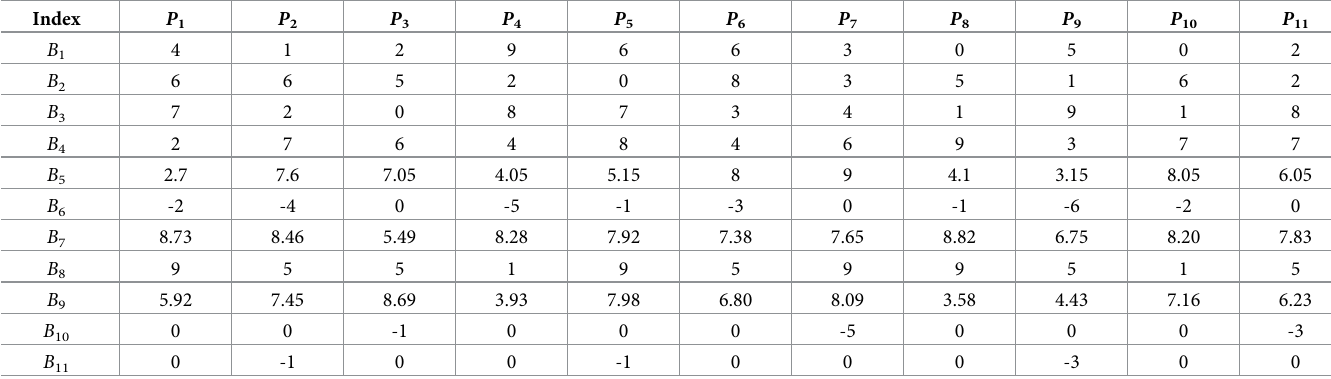
Table 5. Performance of 11 bid evaluation